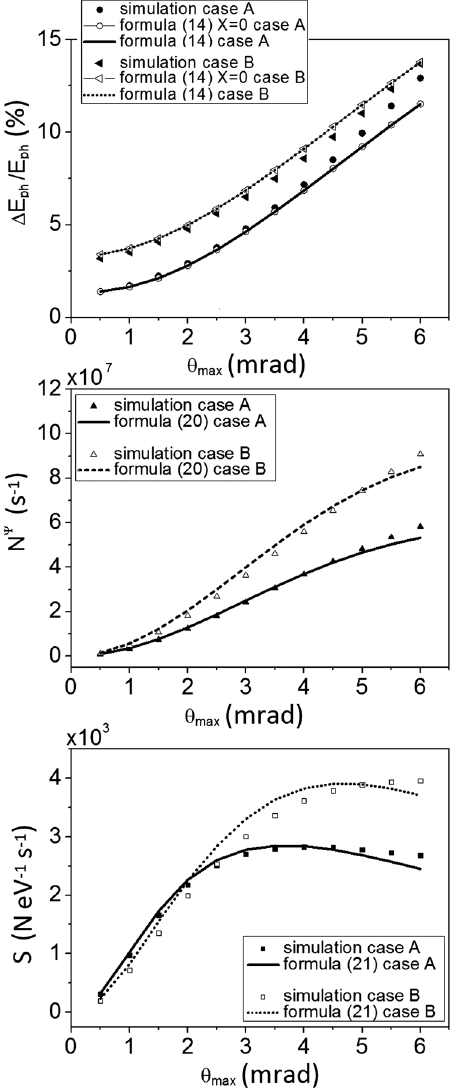
=E FIG. 1. Cases A and B: Δ E (%) from CAIN simulation ph ph vs formula (14) without and with X correction, N Ψ (s − 1 ) number of photons from CAIN simulation vs formula (20), S (N eV − 1 s − 1 ) spectral density per shot ( r ¼ 1 ) from CAIN simulation vs formula (21) as a function of θ max